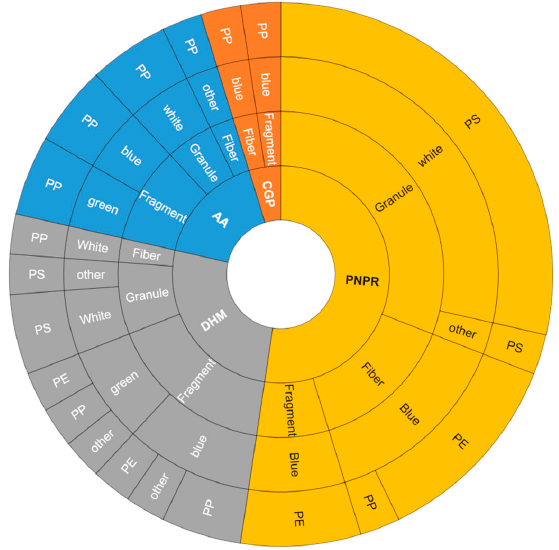
Figure 5. Relationship of chemical composition, shape, and color of microplastics in this study.